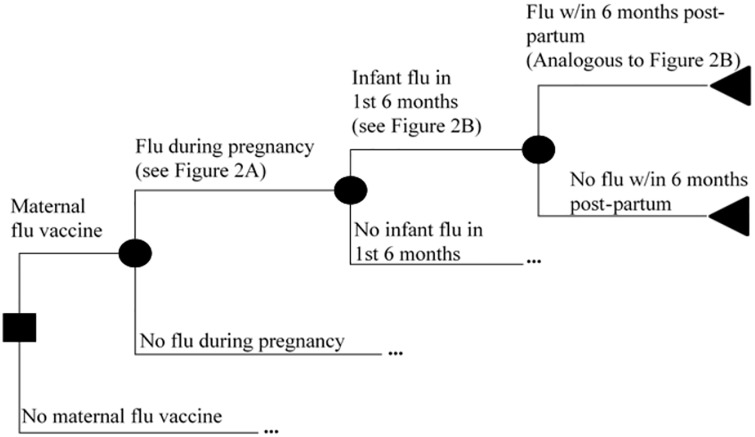
Overall decision-tree model structure.Squares designate decision points. Circles designate probabilistic events. Triangles designate terminal nodes. Ellipses (…) indicate a symmetrical sub-tree that is not shown due to space constraints.